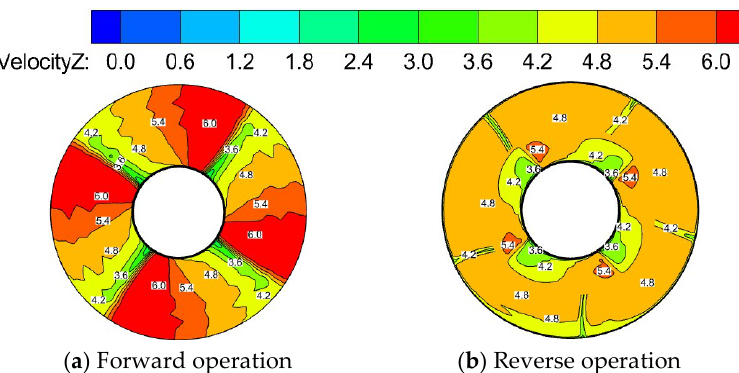
Figure 16. 0.9 Q d impeller inlet axial flow velocity distribution cloud diagram.